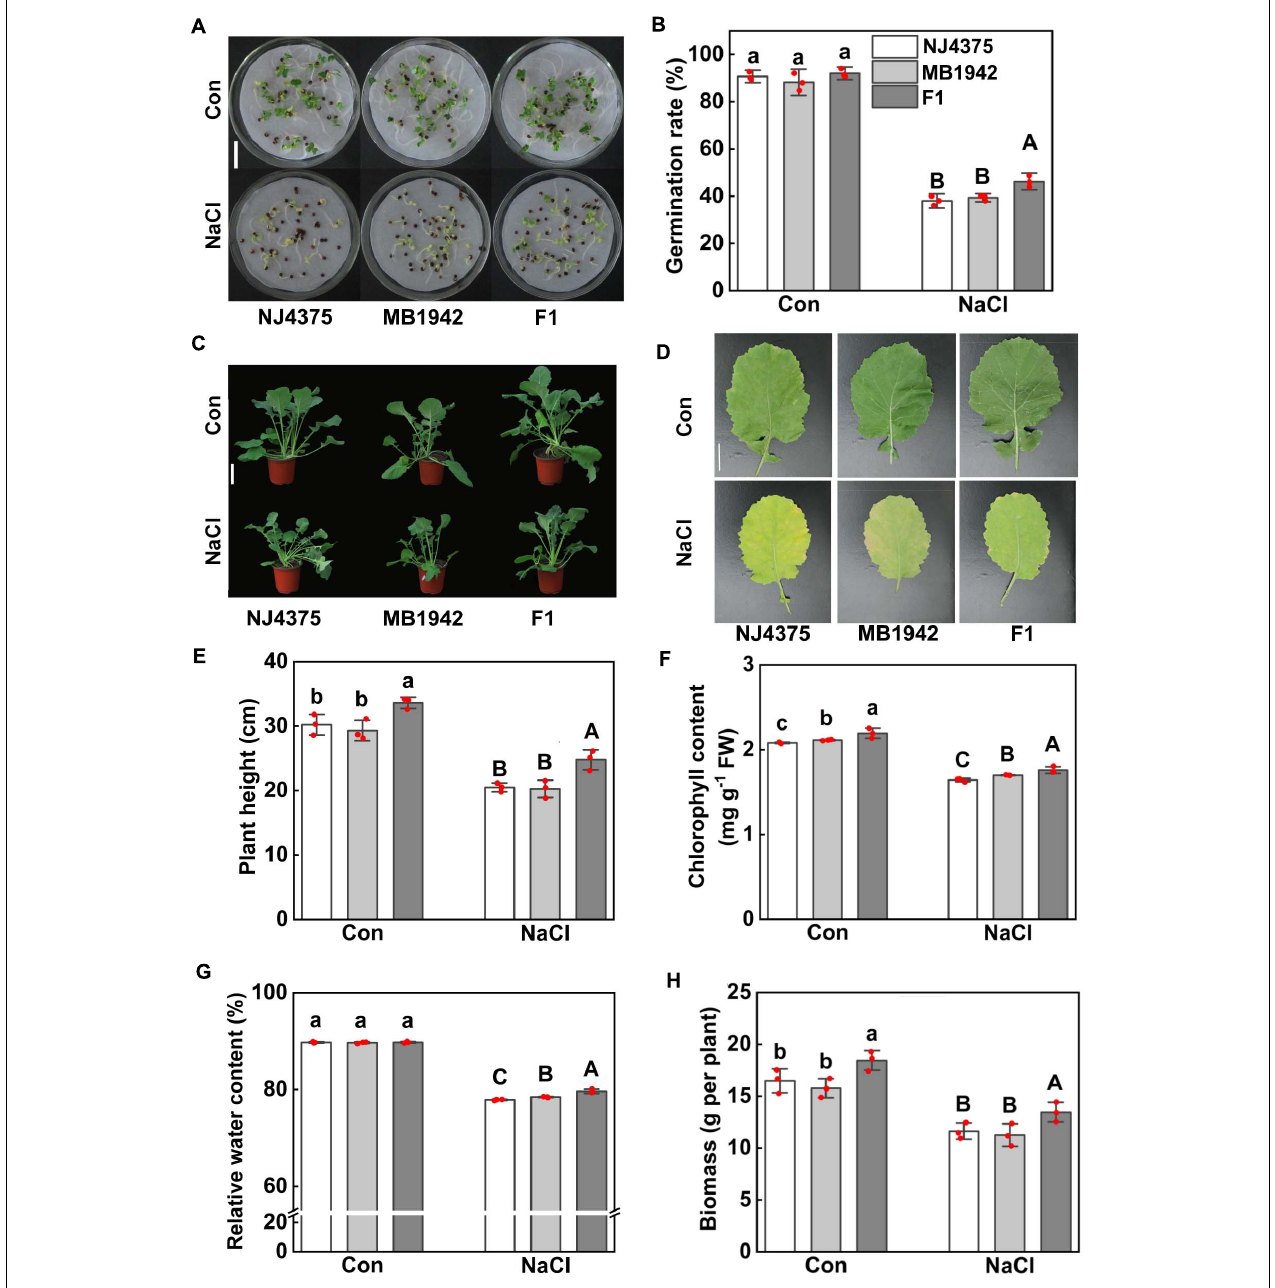
FIGURE 1 | Heterosis of B. napus hybrid (F1) and their parental lines (NJ4375 and MB1942) on the phenotypic manifestation and salt tolerance assays during germination and post-germination. (A,B) Germination stage. Bar = 3 cm. (C,D) Post-germination stage. Bar = 10 cm (C) . The leaves were sampled and photographed. Bar = 3 cm (D) . The plant height (E) , chlorophyll content (F) , relative water content (G) , and biomass (H) were determined. Treatment with distilled water (A,B) or 1/2 Hoagland nutrient solution (C–H) was regarded as control (Con). Values are the means ± SD for three independent experiments. One-way ANOVA analyses were conducted according to Duncan’s multiple range test. Within each set of experiments, bars with different letters denote significant differences at P < 0.05.